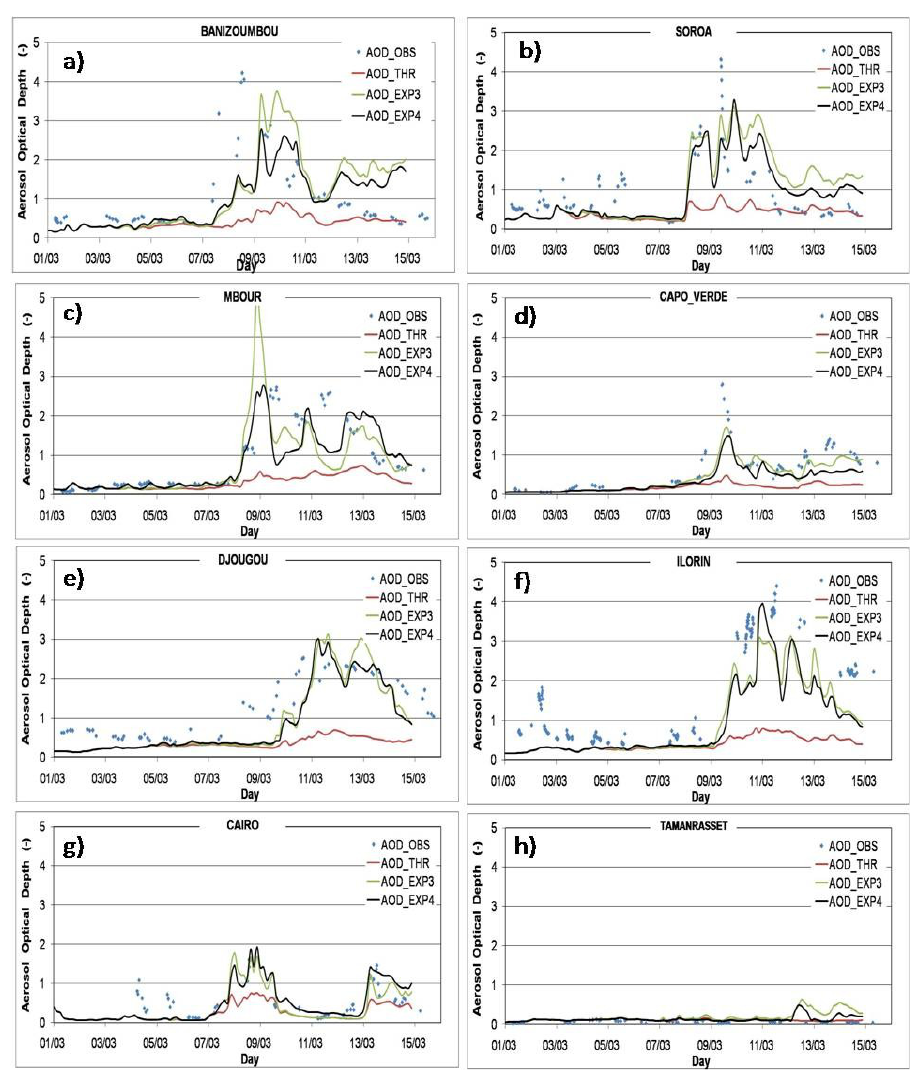
Fig. 13. Evolution of the AOD (at 550nm) simulated by ALADIN with three dust emission schemes: THR (red line), EXP3 (green line) and EXP4 (black line), between 1 and 15 March 2006, over (a) Banizoumbou, (b) Soroa, (c) Mbour, (d) Capo Verde, (e) Djougou, (f) Ilorin, (g) Cairo, and (h) Tamanrasset, compared with AERONET photometer observations AOD 440 (level 2).